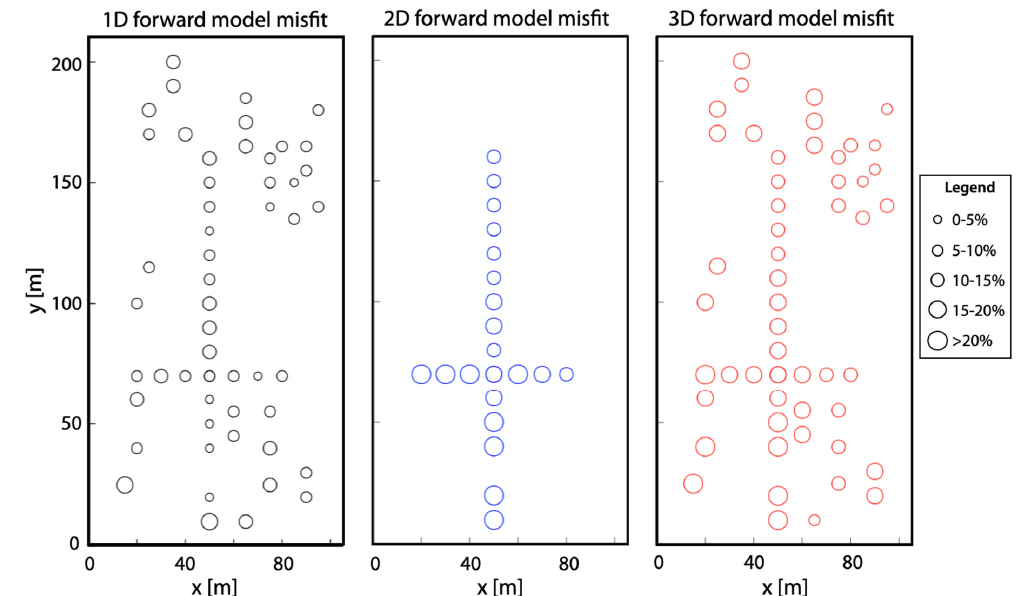
Figure 14. Misfit of 1D, 2D and 3D models, from left to right. Size of circle represents a relative error for each sounding. Only 21 points of misfits are shown for 2D model along 2018 dataset.